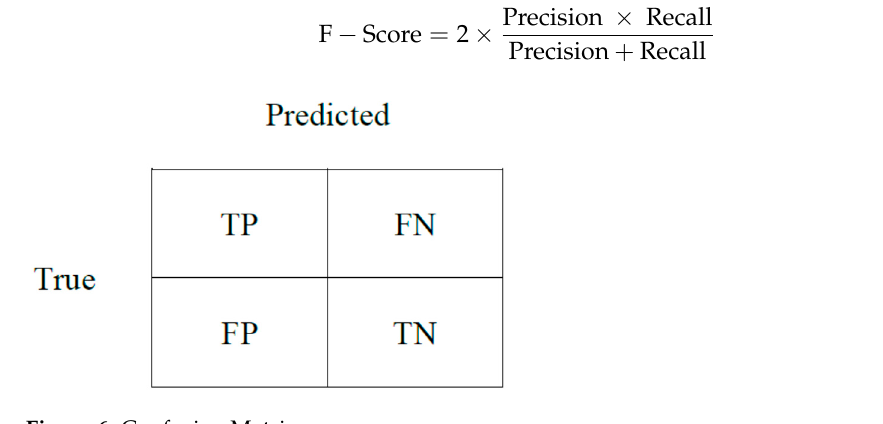
Table 5. Classification results for random stratified